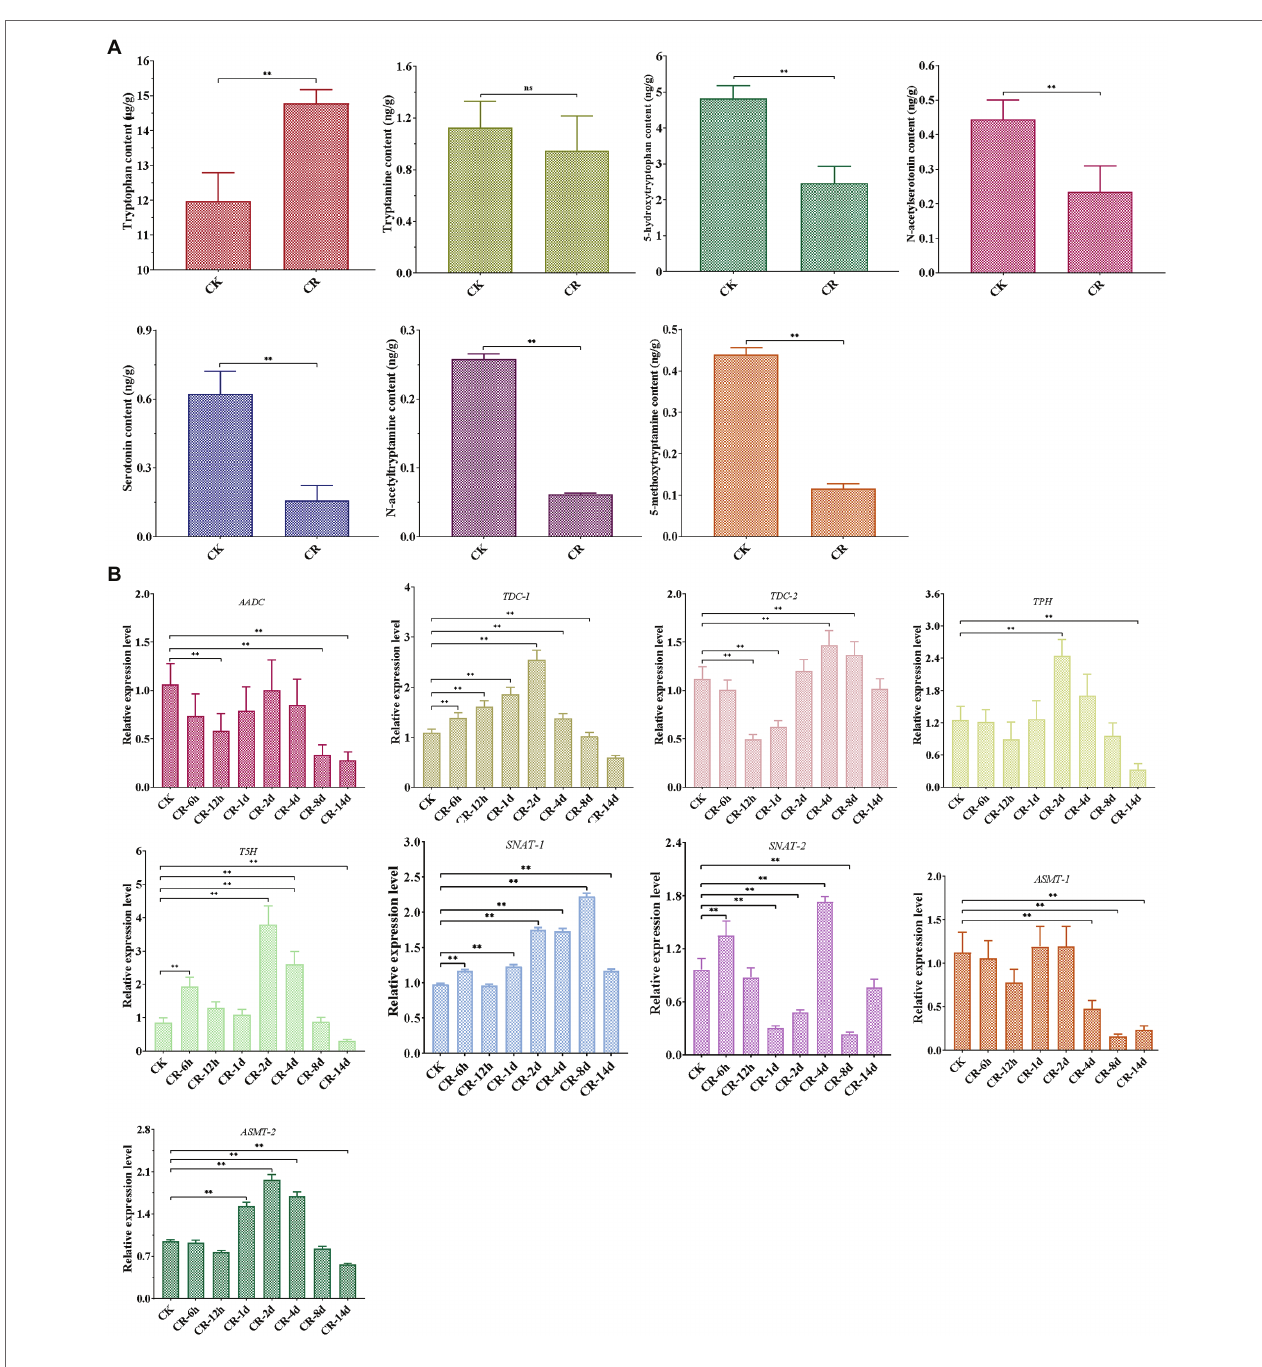
FIGURE 2 | Detection of melatonin-biosynthesis intermediates after 14 d CR treatment (A) and expression patterns of genes related to melatonin synthesis at different periods of CR stress (B) in T . guangdongense . CK, group at 0 h.; CR, congo red; AADC , aromatic-L-amino-acid decarboxylase; TDC , tryptophan decarboxylase; TPH , tryptophan 5-hydroxylase; T5H , tryptamine 5-hydroxylase; SNAT , serotonin N-acetyltransferase; ASMT , acetylserotonin O-methyltransferase; ns, no significant difference. ** , highly significant differences ( p <